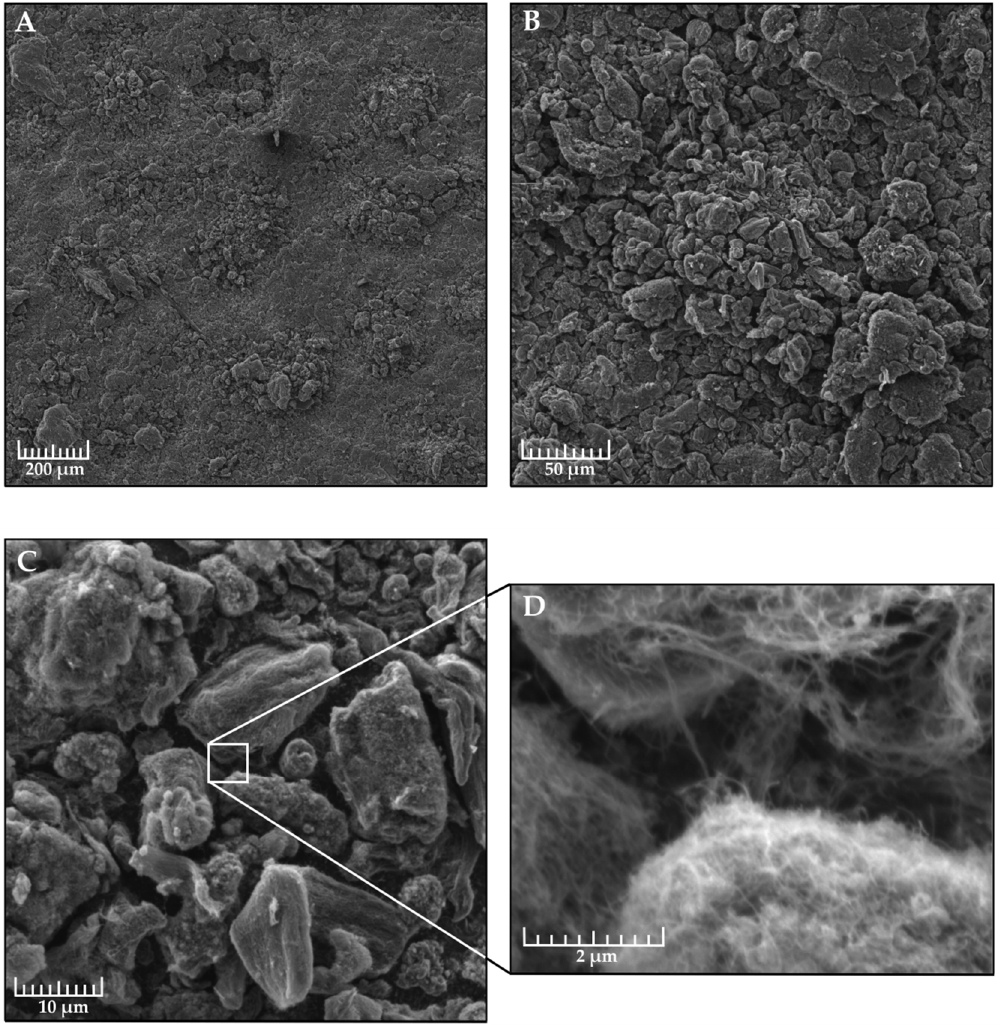
Figure 5. Superhydrophobic surface at various zoom degrees. The sample is made of xerogel based on Taunit-MD CNTs and ethanol, the fraction size equals 0.125–0.100 mm. Section A —200 times magnification, a coating defect is visible at the top. At these points, the development of icing begins. Section B —magnification 1000 times. Section C —10,000 times. Section D —an increase of 40,000 times, individual CNTs are visible. The image was obtained through a Tescan Vega 3 scanning electron microscope.